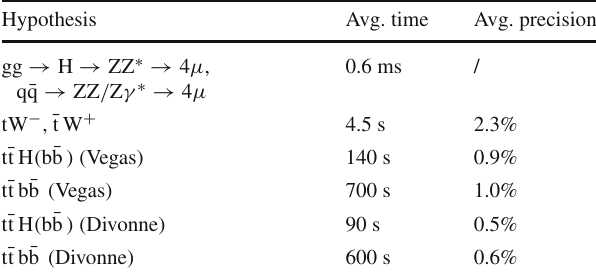
Fig. 3 Left:signalinformationunderthesignalhypothesis(t ¯ t H).Right:discriminatingvariablebuiltfromtheweightsinthesignalandbackground hypotheses. All distributions are normalised to unity Table 3 Average computation time of weights under the different hypotheses used in Sect. 4. The average relative precision on the result- ing weights are also given Hypothesis Avg. time